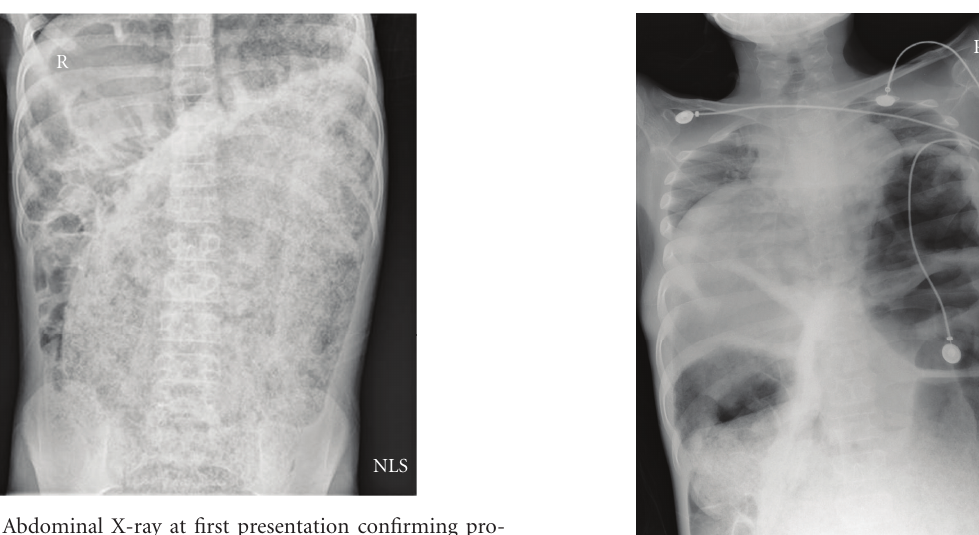
Figure 1: Abdominal X-ray at first presentation confirming pro- found constipation with large fecaloma.